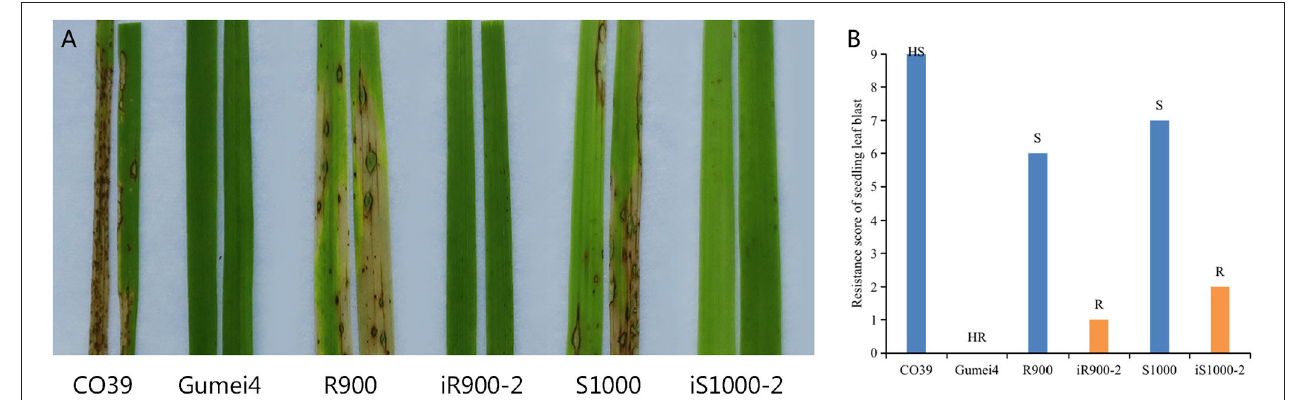
FIGURE 6 | Evaluation of seedling blast resistance of six rice genotypes. (A) Disease reactions of the rice genotypes, including the S (CO39) and R (Gumei4) checks, to a mix of four isolates by using spraying inoculation. (B) Resistance score and resistance level. HR, highly resistant; R, resistant; MR, moderately resistant; S, susceptible; HS, highly susceptible.